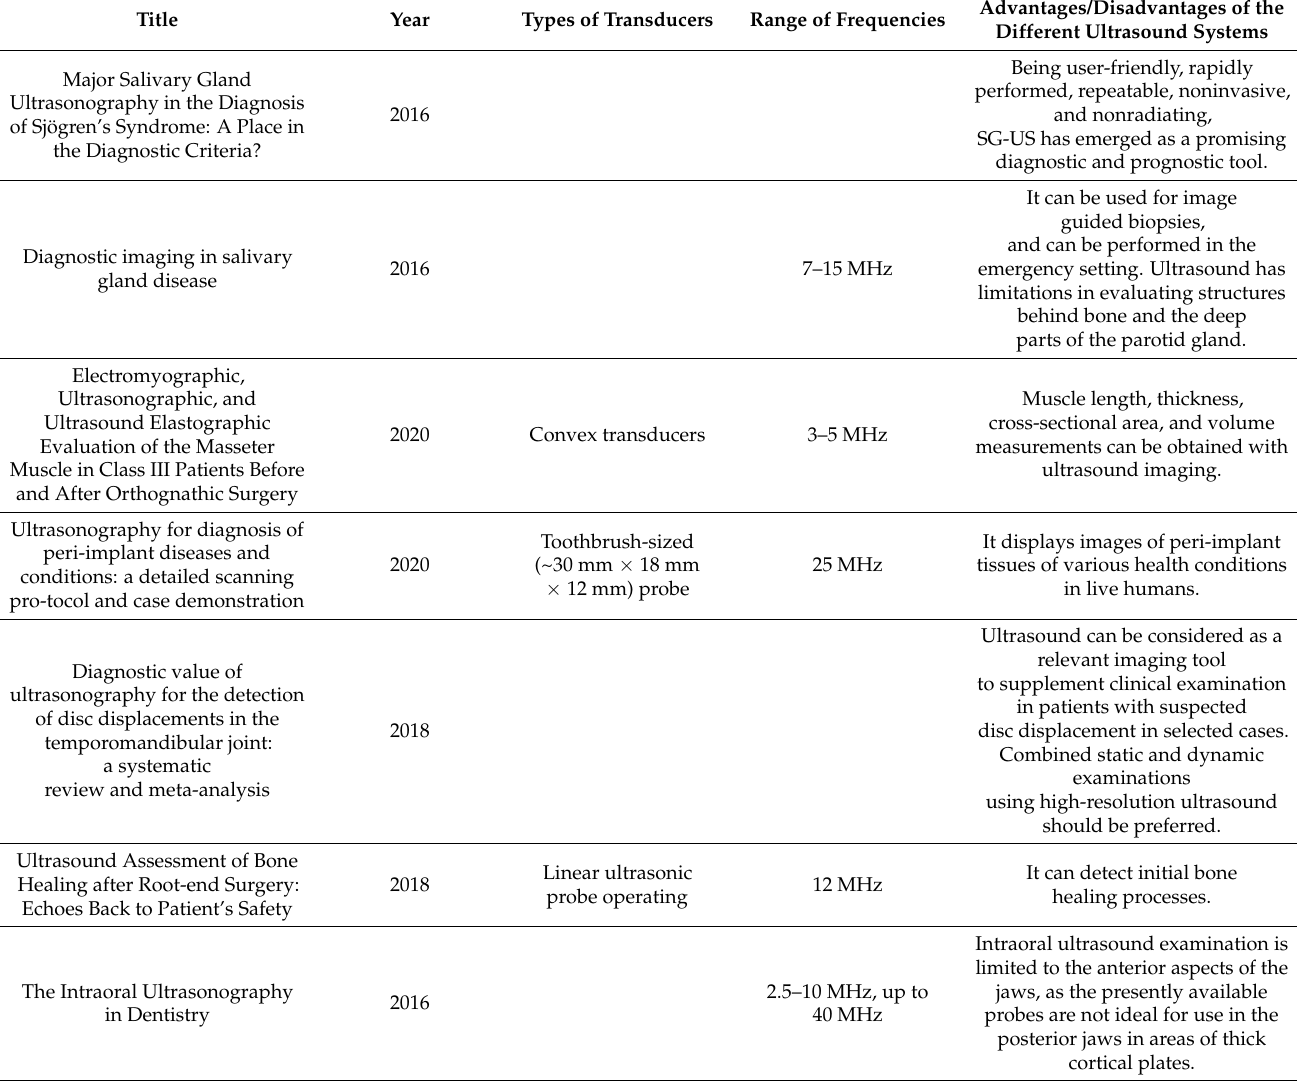
Table 2. Technical